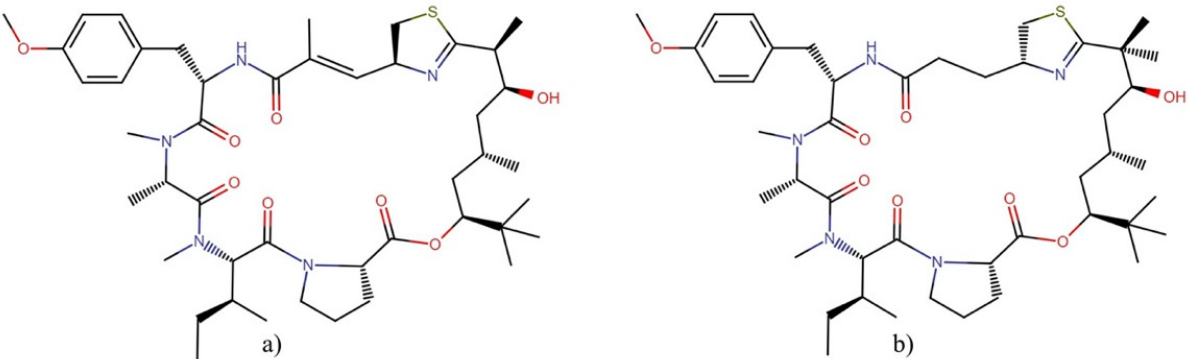
Figure 7. Chemical structures of ( a ) apratoxin A and ( b ) apratoxin S10. All molecules from this family are available in Supplementary Figure S1.